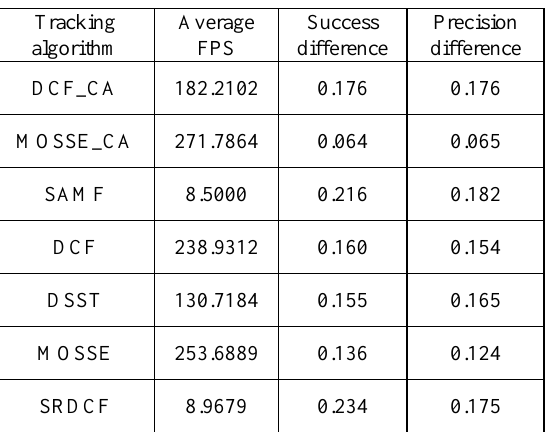
Table. 1. Trackers average FPS, success rate difference for semi- automatic and ground truth initialization with IoU > 0.5 and precision difference for semi-automatic and ground truth initialization with 20-pixel precision